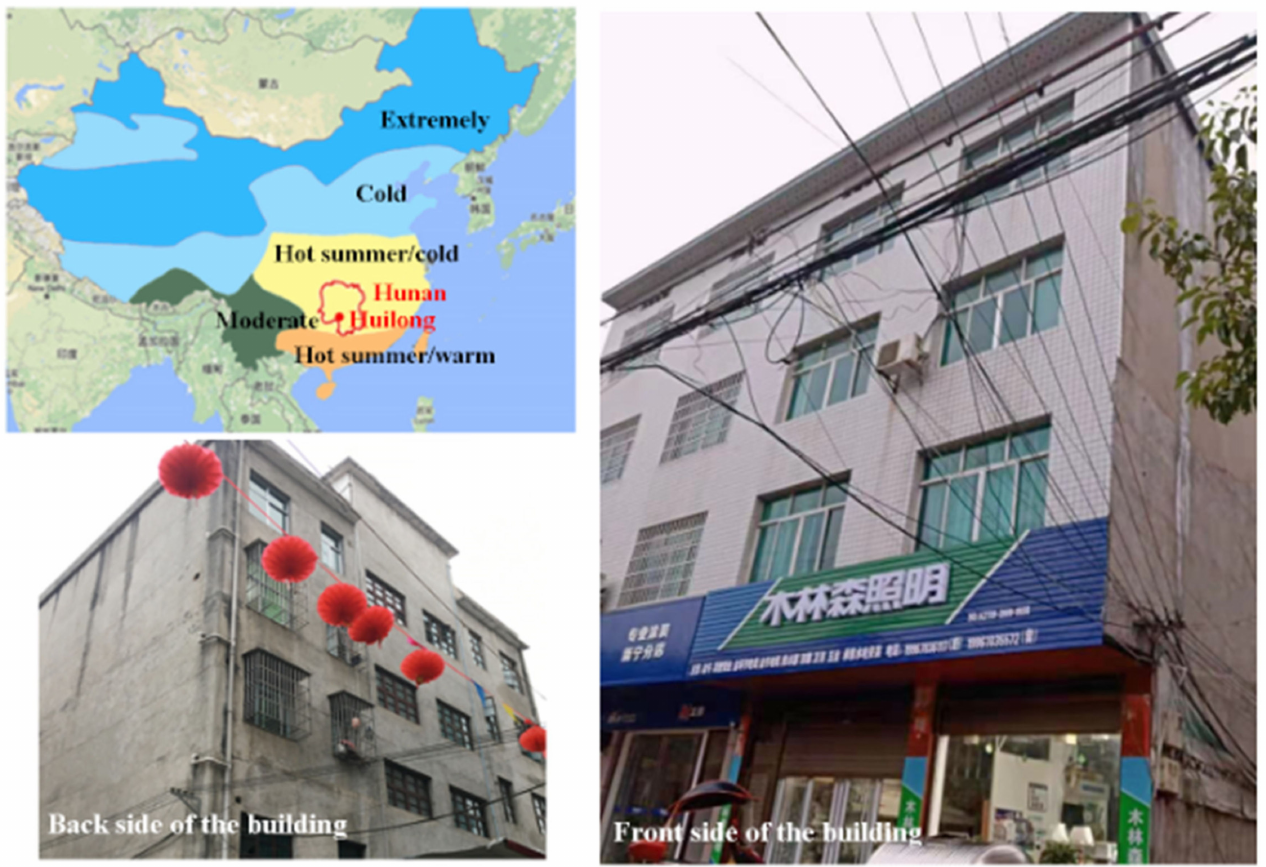
Figure 1. View of the Huilong case-building (photos were taken by the author) and its location on the China climate zone map, map sourced from [30].